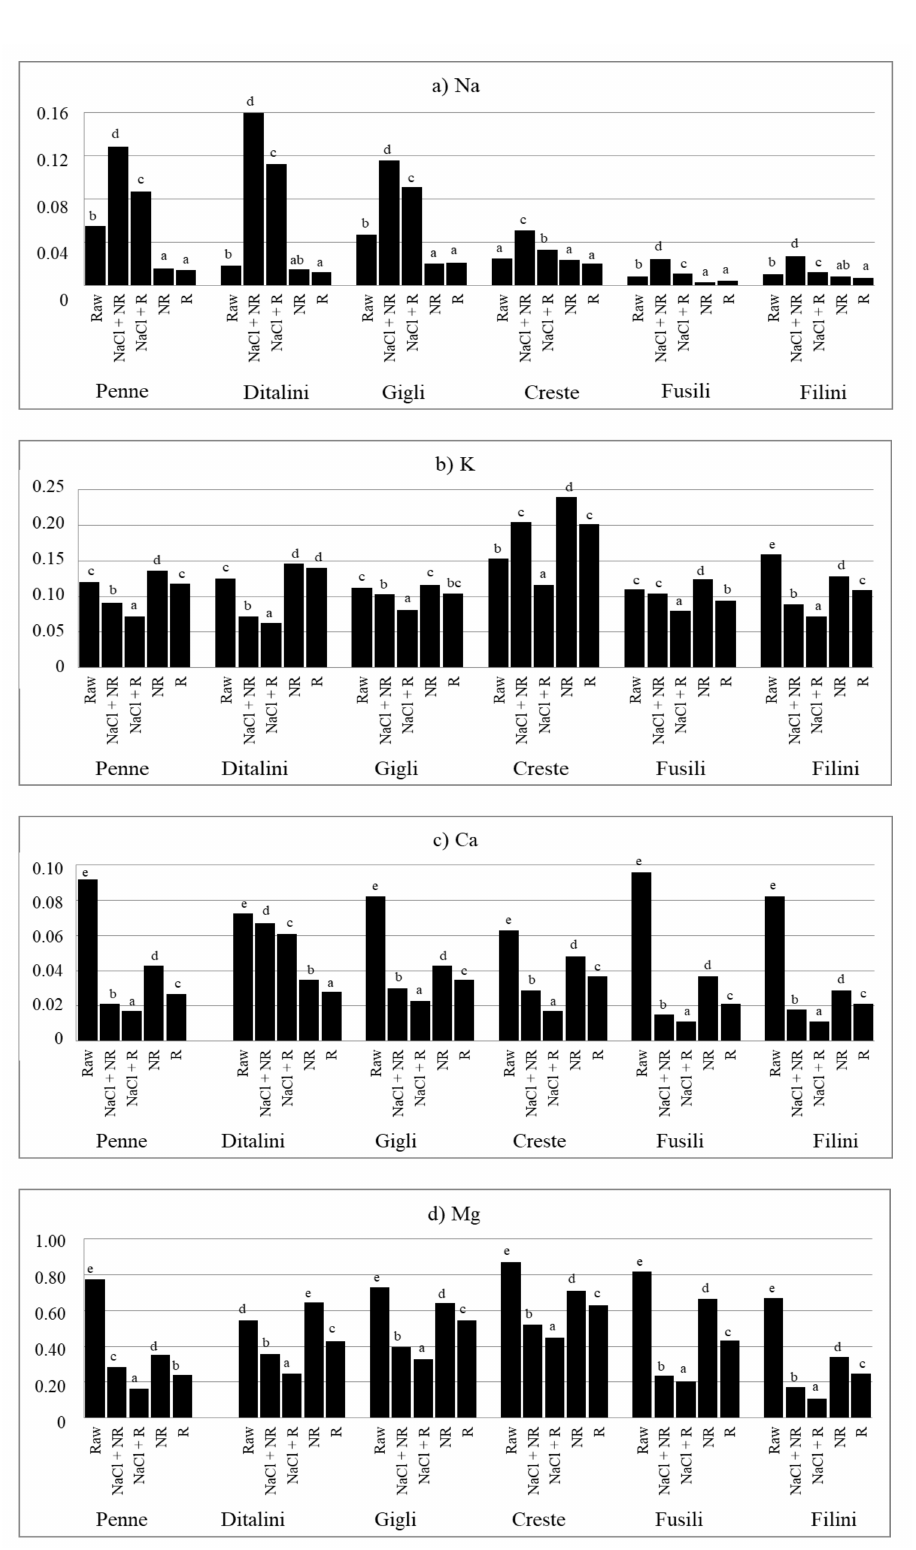
Figure 1. The content of: ( a ) Na; ( b ) K; ( c ) Ca; ( d ) Mg in pasta, g kg − 1 fresh weight. Raw—raw pasta; NaCl + NR—cooked with salt and not rinsed; NaCl + R—cooked with salt and rinsed; NR— cooked without salt and not rinsed; R—cooked without salt and rinsed; a,b,c,d,e —values with different superscripts differ at p < 0.05 by Duncan’s